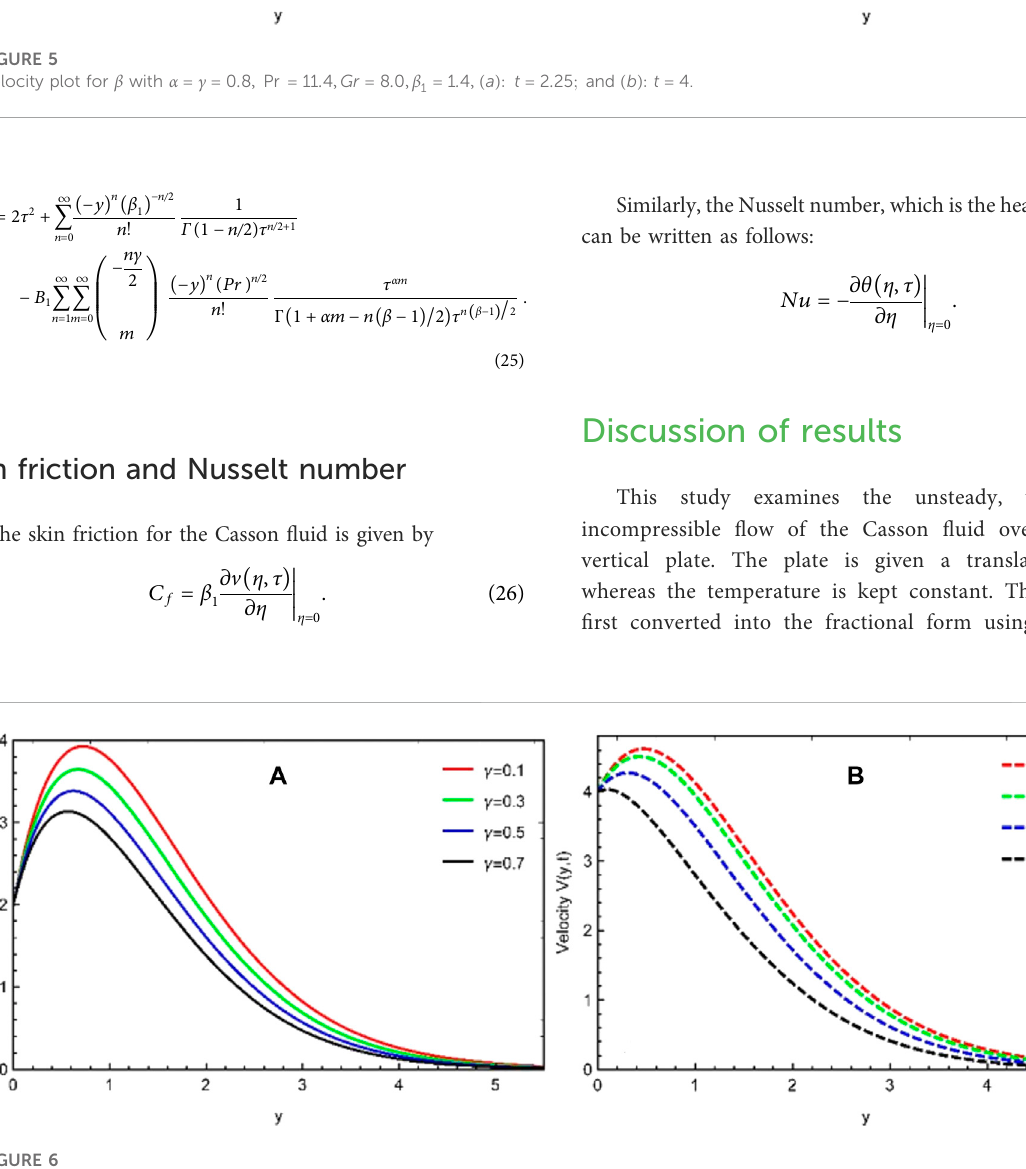
FIGURE 6 Velocity plot for γ with α (cid:3) β (cid:3) 0 . 8 , Pr (cid:3) 11 . 4 , Gr (cid:3) 8 . 0 , β 1 (cid:3) 1 . 4 , ( a ) : t (cid:3) 2 . 0 ; and ( b ) : t (cid:3)